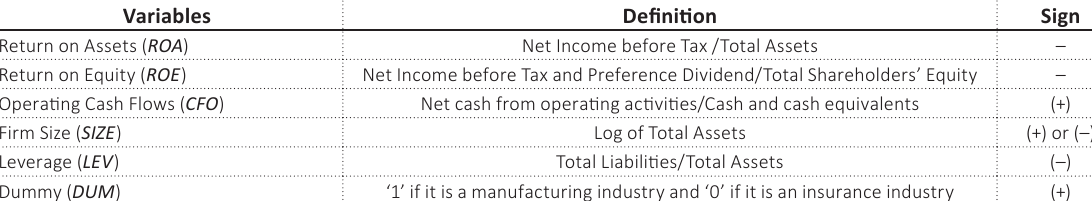
Table 1. Definitions of dependent and independent